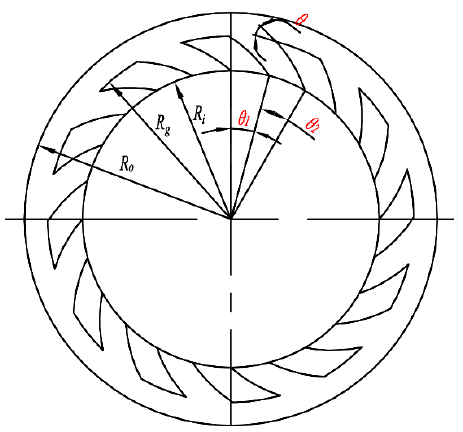
Figure 1. Structure of end face of rotating seal ring.